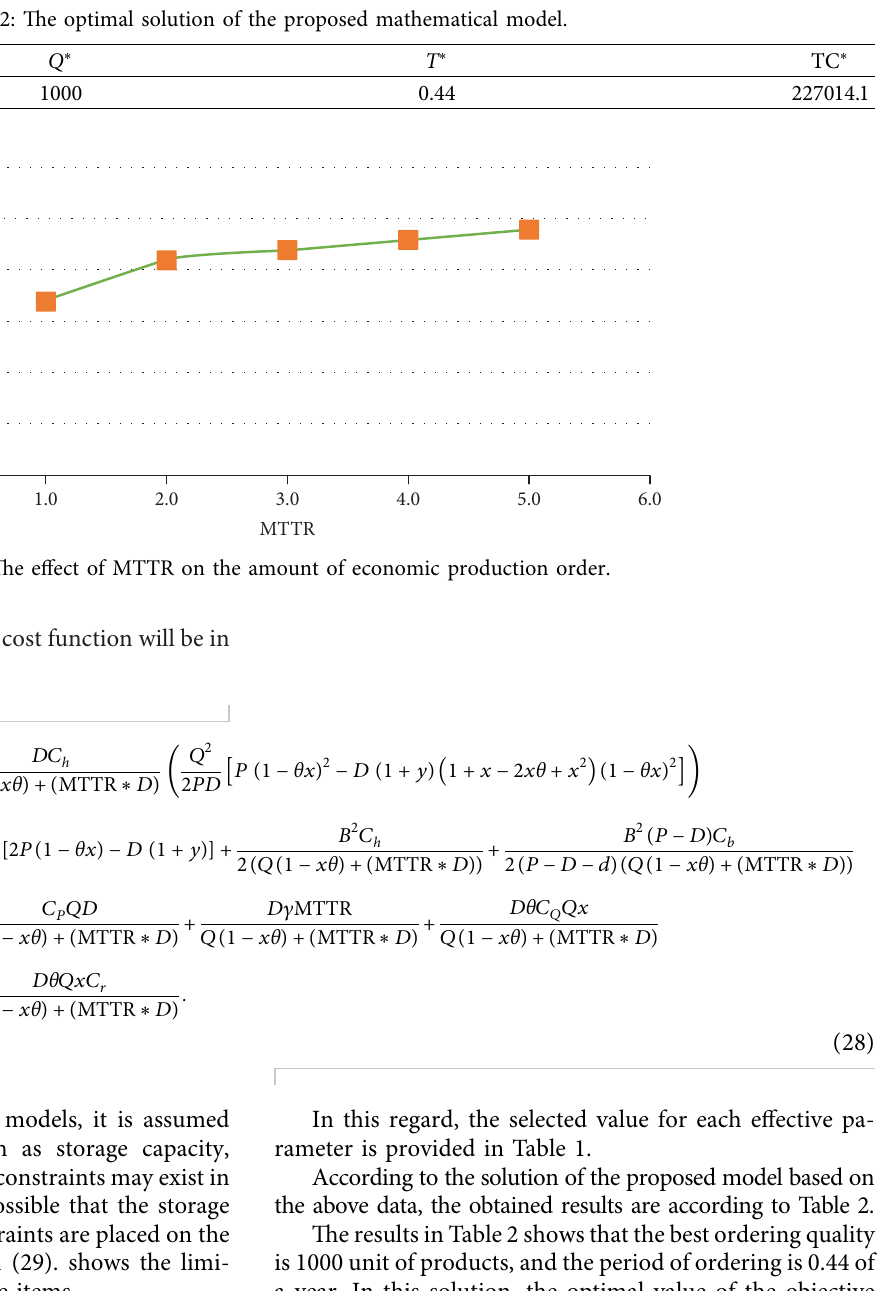
Table 2: Te optimal solution of the proposed mathematical model.